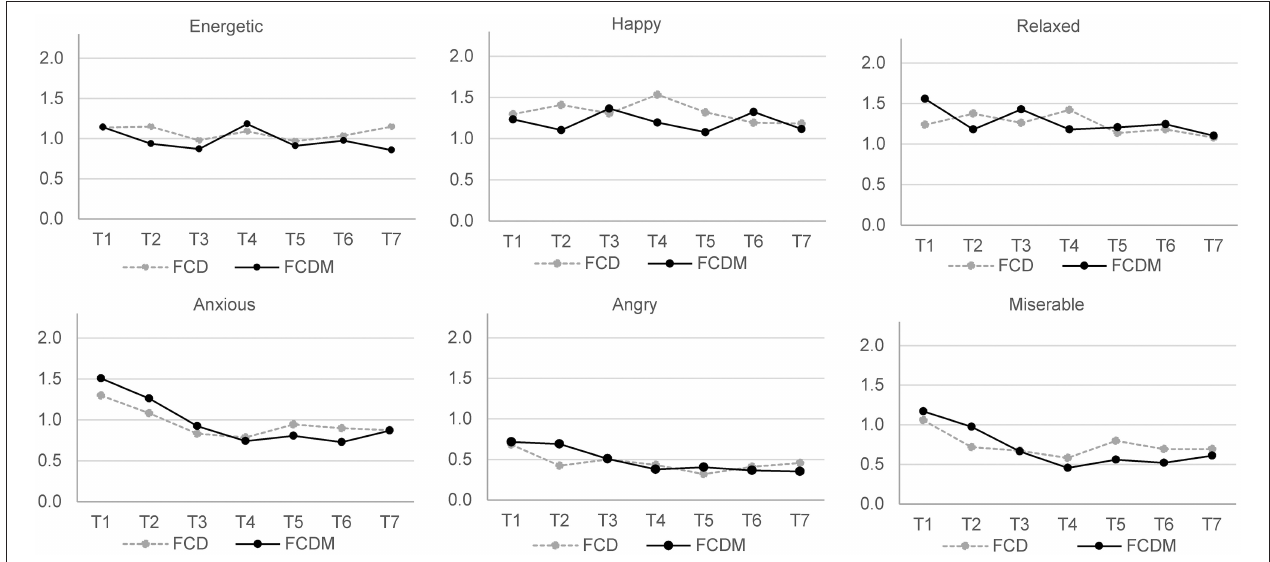
FIGURE 3 | Intensity of emotional states associated with strongest food cravings across a 7-day intervention (FCD, n = 88; FCDM, n = 77).